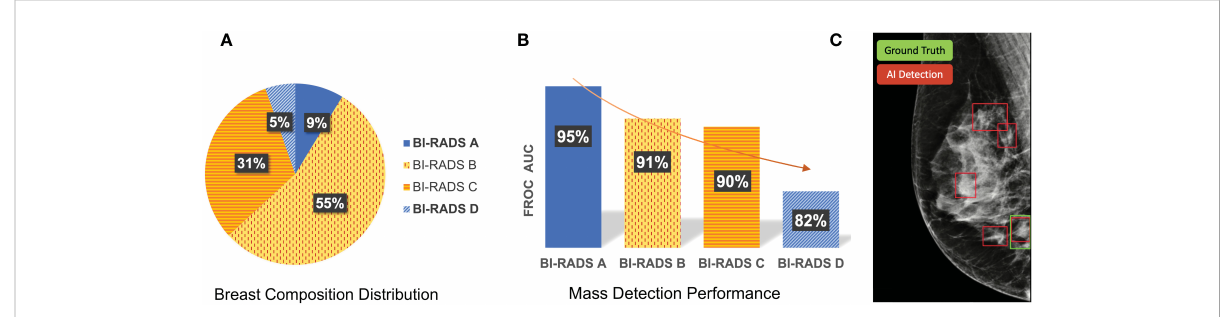
FIGURE 1 Differences in sensitivity of a deep learning-based mass detection model by breast density composition in full- fi eld digital mammography. (A) Breast composition distribution of the training set. (B) Mass detection sensitivity by breast density. (C) Output of an automated detection model in a high-density (BI-RADS D) image. The red bounding boxes are the AI model outputs and the green box corresponds to the true mass, summing a total of four false